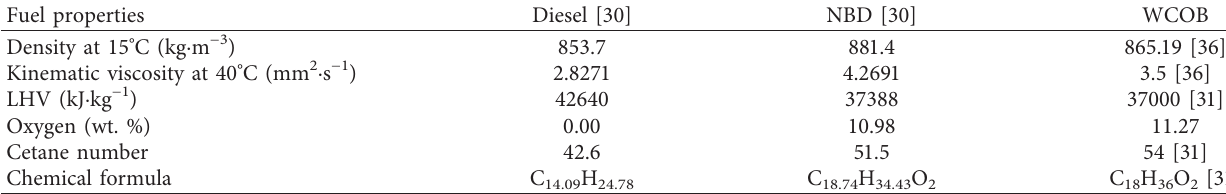
Table 3: Chemical and physical properties of test fuels.